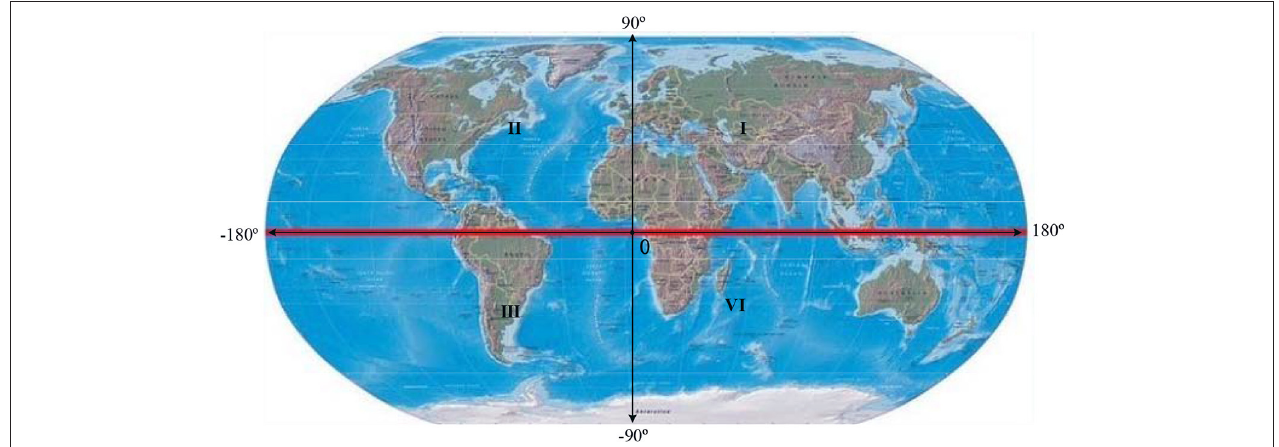
FIGURE 3 | The map of the Earth’s magnetic field.